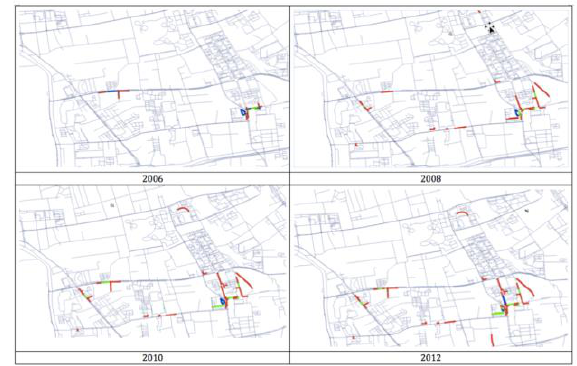
Figure 2. Changes in the degree of satisfaction for beauty